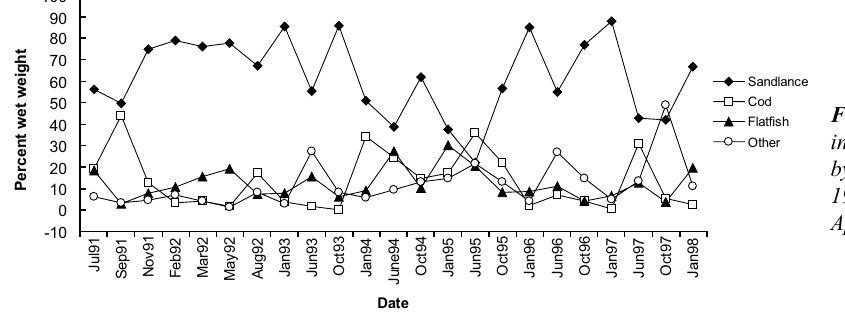
Fig. 2 Interannual variation in the major prey taxa eaten by grey seals at Sable Island,